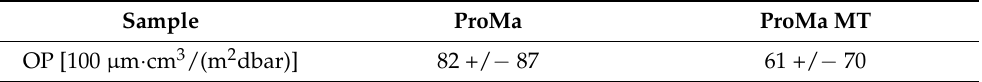
Table 1. The oxygen permeability (OP) of the ProMa barrier coating and the multilayer coating ProMa MT, n = 6.